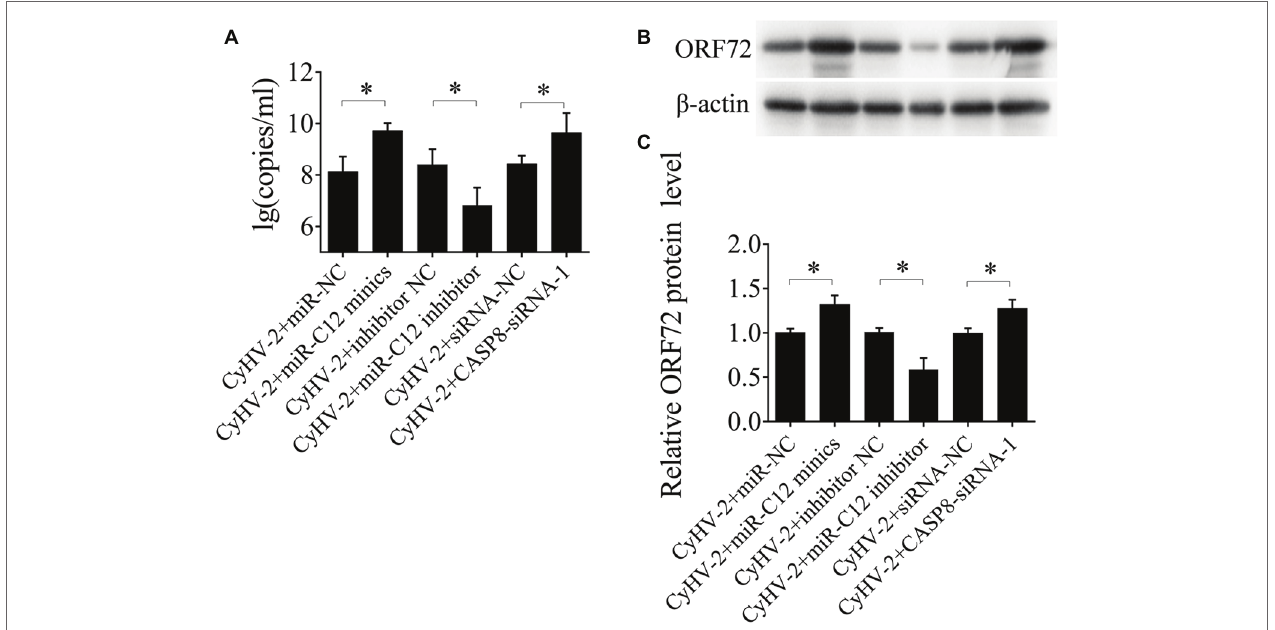
FIGURE 6 | Role of miR-C12 in the CyHV-2 propagation. GiCF cells were infected with CyHV-2 (MOI = 0.1) and transfected with miR-NC, miR-C12 mimics, inhibitor NC, miR-C12 inhibitor, siRNA-NC, or CASP8-siRNA-1 2 h post infection. The infected cells were then collected and subjected to qRT-PCR (A) or Western blot (B) to detect CyHV-2 propagation. (C) Bar graphs displaying the ORF72 protein level.